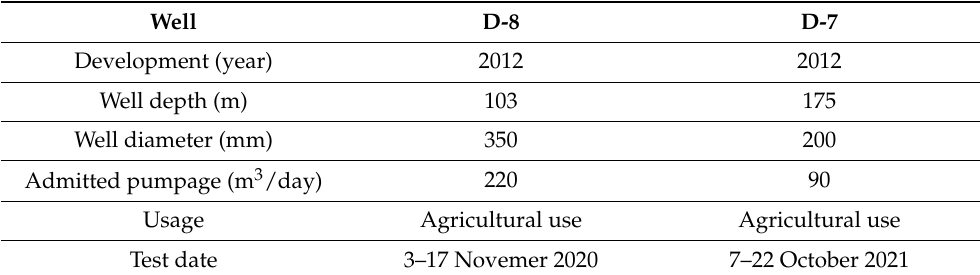
Table 1. Air surging wells for well